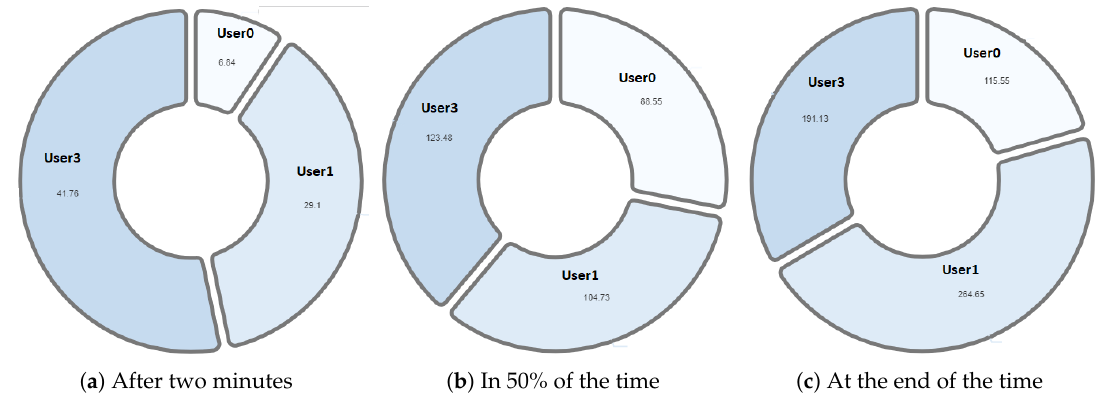
Figure 20. Pie chart with the evolution of G4 speech time